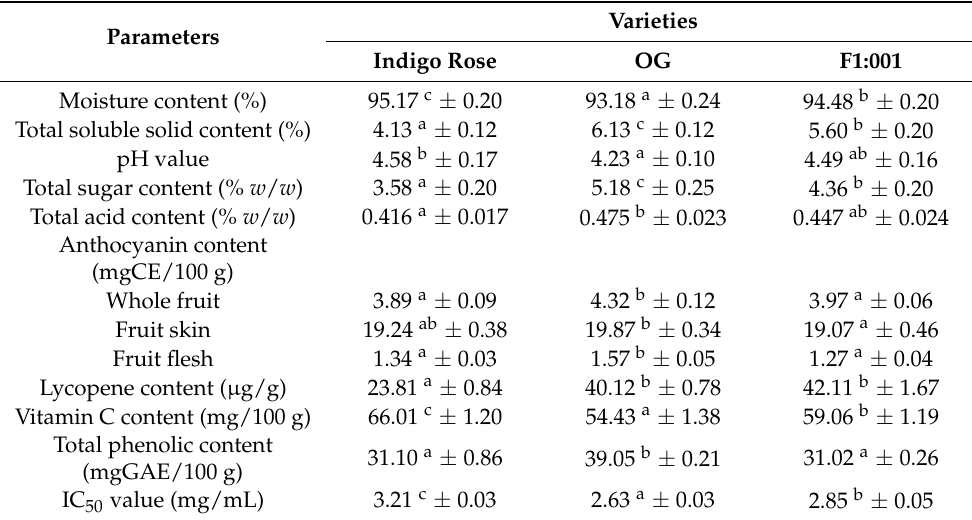
Table 2. Physicochemical, bioactive compounds and antioxidant activity of three black cherry tomato varieties.